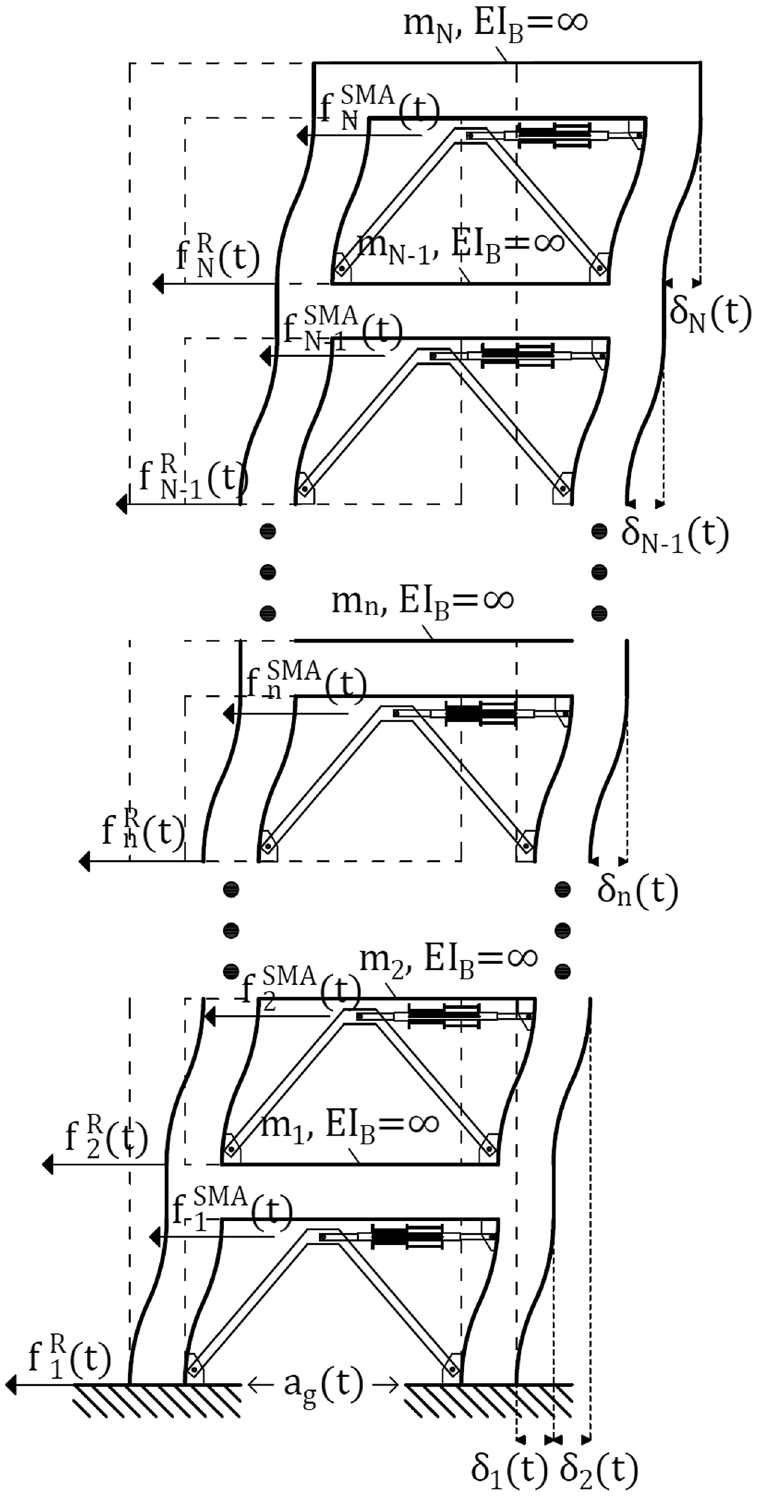
Figure 1. Elevation scheme of a shear-type frame system that undergoes lateral